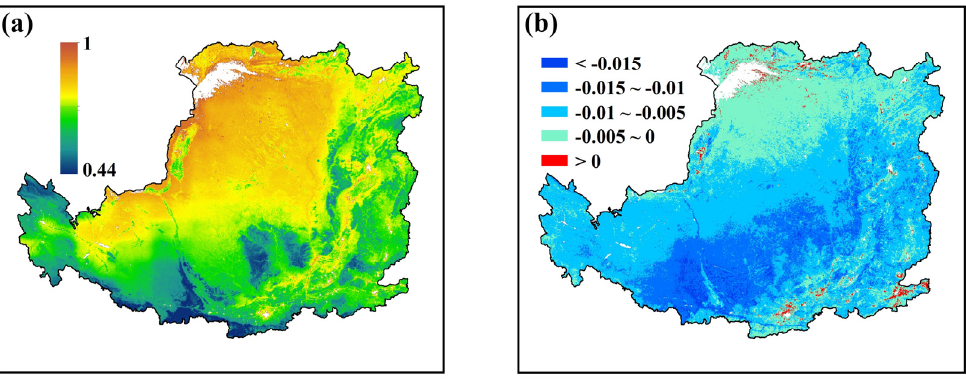
Figure 4. The spatial distribution of the mean annual ESI on the LP during 2000–2015 ( a ) and its slope trends ( b ).